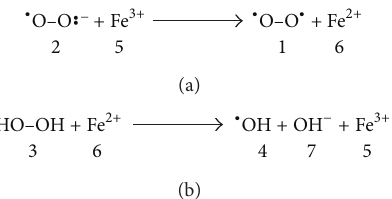
Figure 1: Haber-Weiss and Fenton reactions. (a) Fe 3+ (5) is reduced to Fe 2+ (6) by one-electron transfer from superoxide radical anion (2) to give dioxygen (1). (b) Fe 2+ (6) is oxidized back to Fe 3+ (5) by hydrogen peroxide (3) leading to the formation of hydroxyl radical (4) and hydroxide (7).